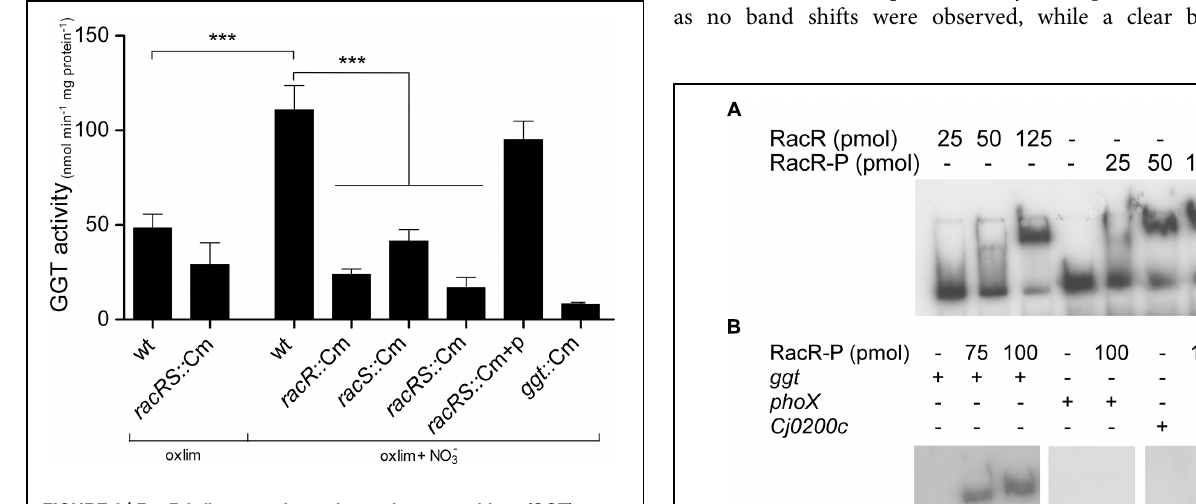
FIGURE 2 | RacR influences the γ -glutamyltranspeptidase (GGT) activity. GGT activity was measured in cell lysate from stationary phase (20 h) cultures of wildtype 81116, the racR, racS, and racRS mutant strains, as well as the complemented racRS mutant, grown in HI medium at oxygen limiting conditions with or without the addition of nitrate. Mean and SE of at least three independent experiments are shown. ∗∗∗ p < 0.001.